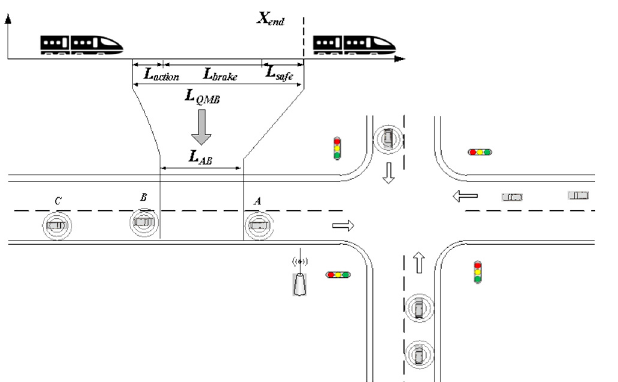
Figure 2 Track process of QMB theory in speed guidance